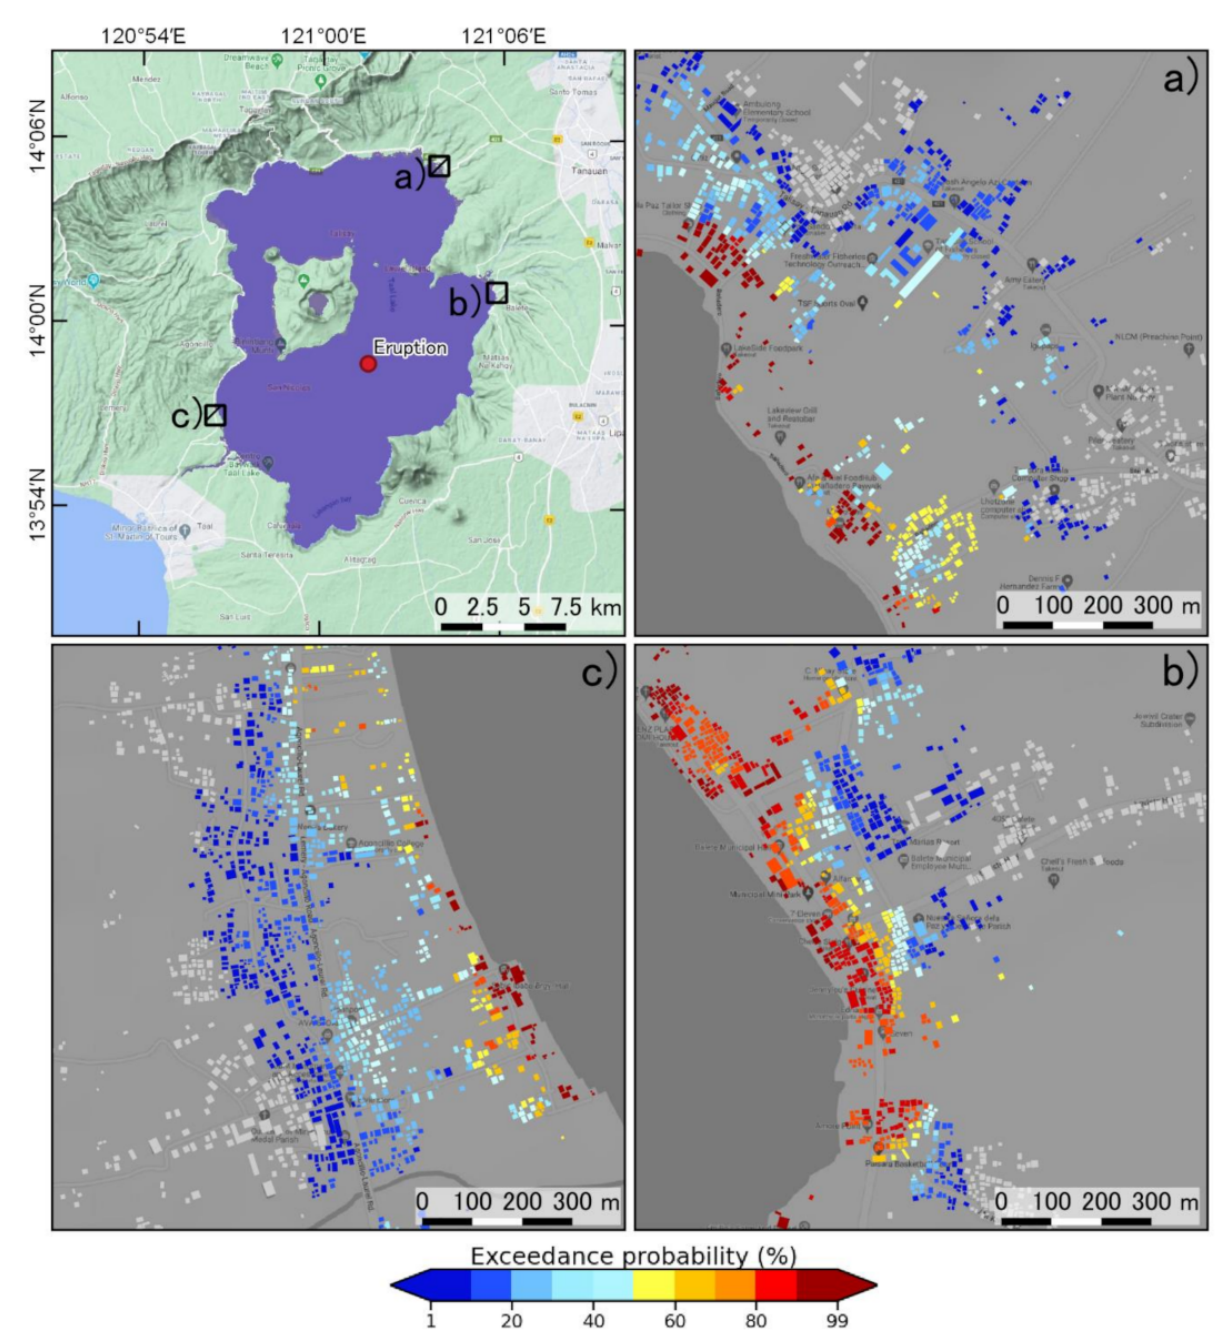
Figure 14. Probability of experiencing a tsunami inundation depth of more than 3.0 m in some example areas. ( a ) northern coastal area, ( b ) coastal area near to the eruption point, and ( c ) southern coastal